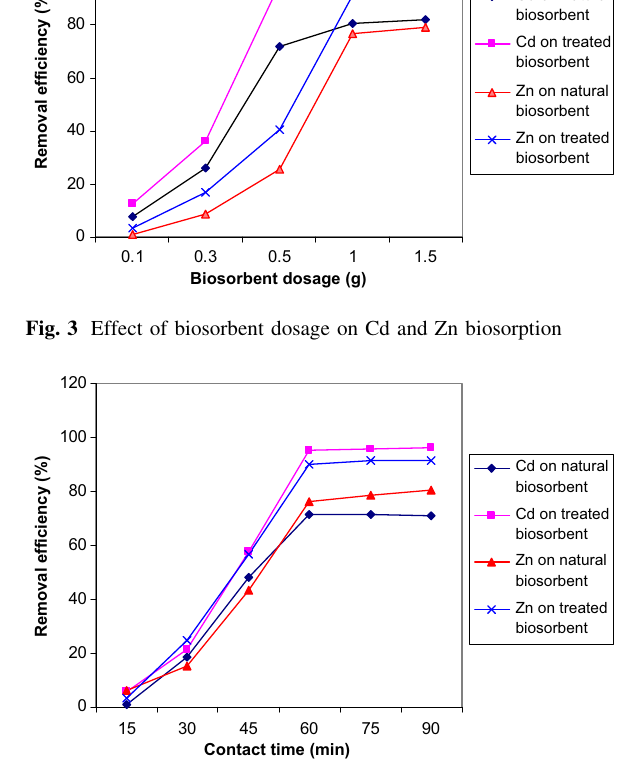
Fig. 4 Effect of contact time on Cd and Zn biosorption